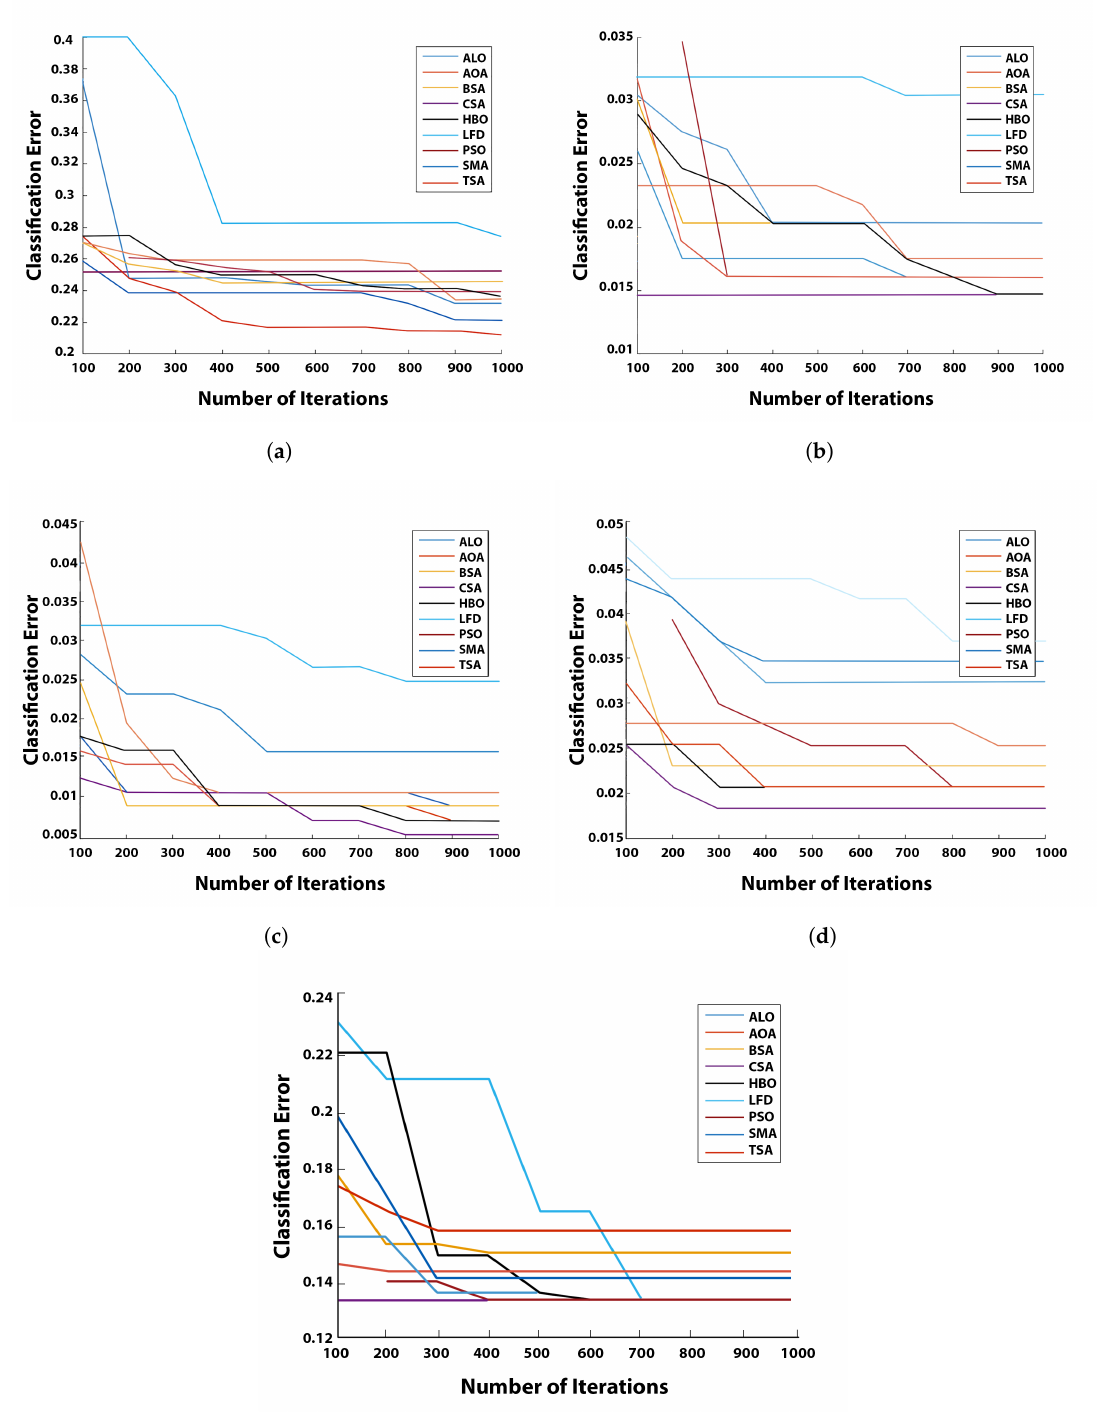
Figure 2. ( a ) Convergence Curve of the proposed approach for Arrhythmia dataset; ( b ) Convergence Curve of the proposed approach for Breast-cancer dataset; ( c ) Convergence Curve of the proposed approach for BreastEW dataset; ( d ) Convergence Curve of the proposed approach for CongressEW dataset; ( e ) Convergence Curve of the proposed approach for Diabets dataset. Convergence Curve of the proposed approach (B_HBO) over 1000 iterations as a stop criterion for Arrhythmia, Breastcancer, BreastEW, CongressEW, and Diabetes